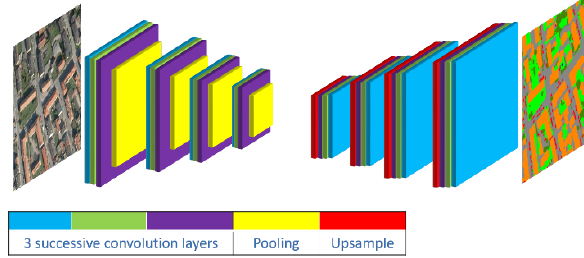
Figure 1: Architecture of